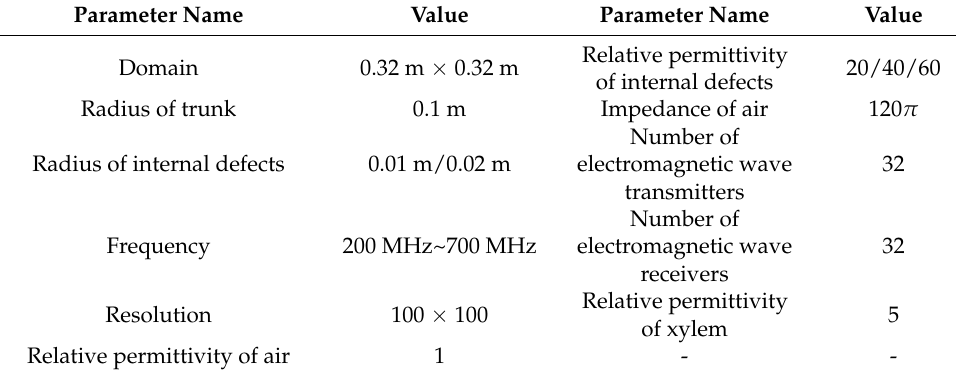
Table 2. Simulation model parameter